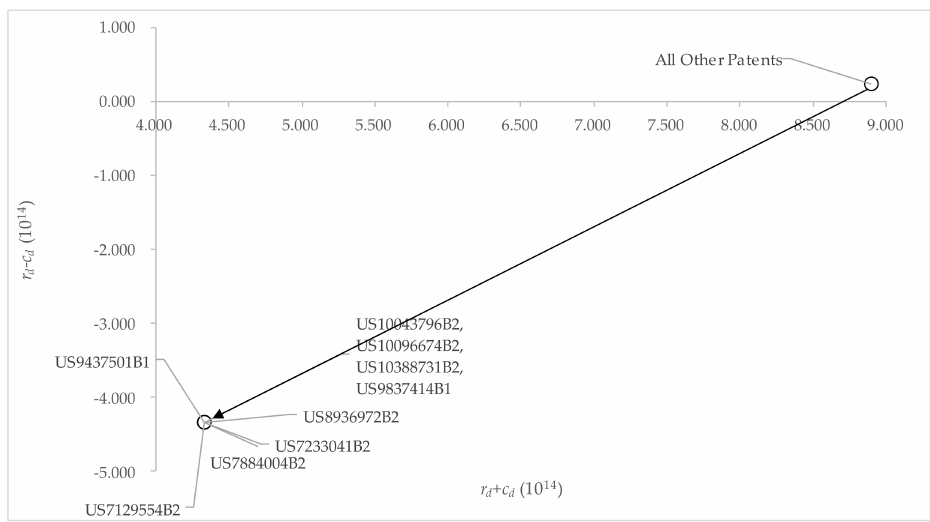
Figure 5. The IRM of the second empirical case. After deriving the IRM, the weights associated with the 175 patents will be derived. which is derived by using the DEMATEL introduced in Section 3.2. Then, the matrix T d is transposed based on the definition of DANP. The weighted supermatrix Π (refer Table 11) patent (5.714 × 10 − 3 ) can be derived